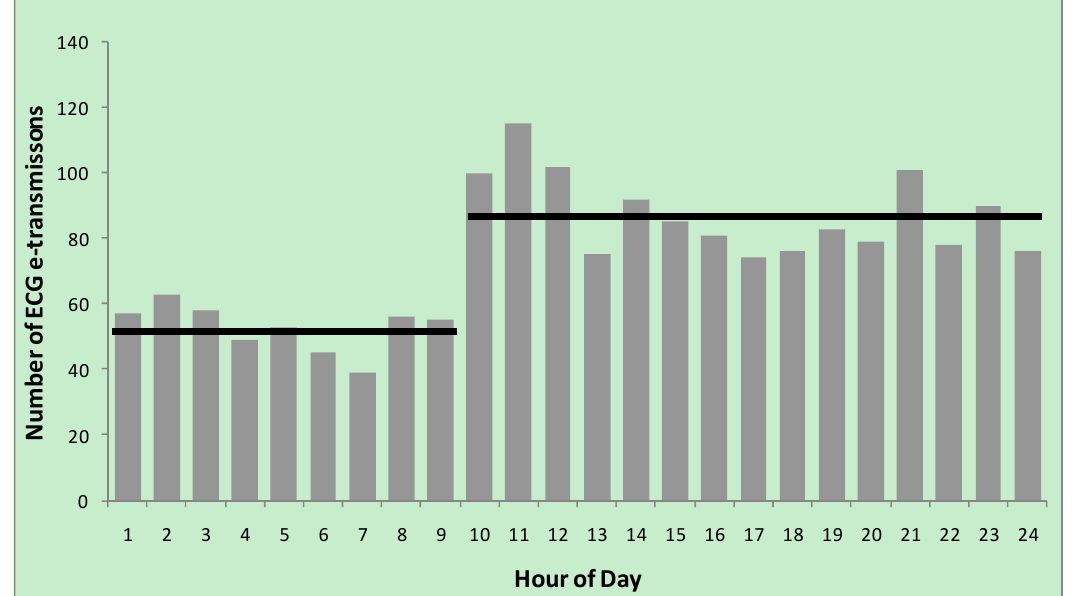
Figure 2. Diurnal variation in e-transmission of ECG; horizontal bars represent the mean number of transmissions for the hours spanned by the